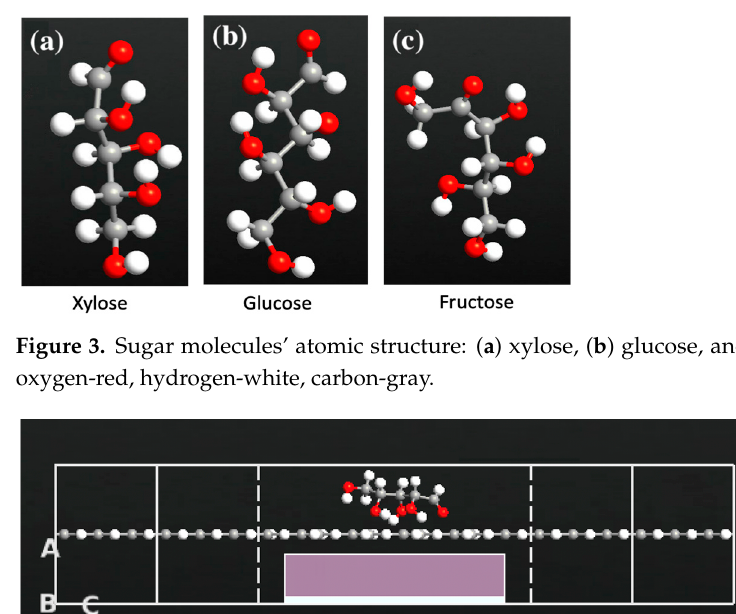
Figure 2. GNR-FET sensor designed by ATK-VNL. ( a ) Schematic representation of the GNR-FET sensor. ( b ) Cross-sectional view of the GNR-FET sensor. The designed sensor is made of a pair of metallic ZGNR (source and drain), an AGNR channel and a gate underneath the channel. Color code: hydrogen-white, carbon-gray.